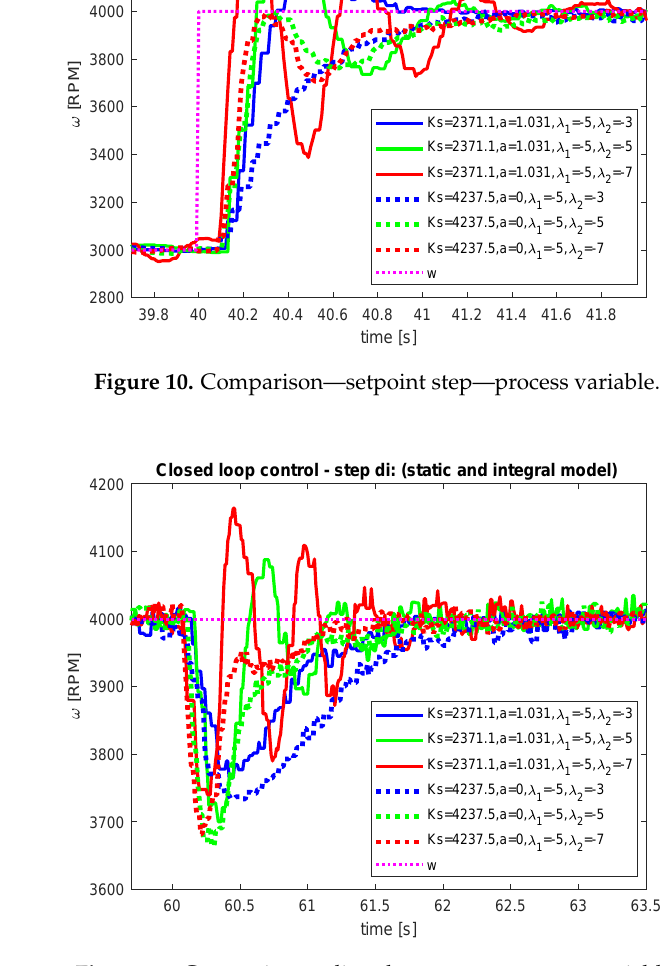
Figure 11. Comparison—disturbance step—process